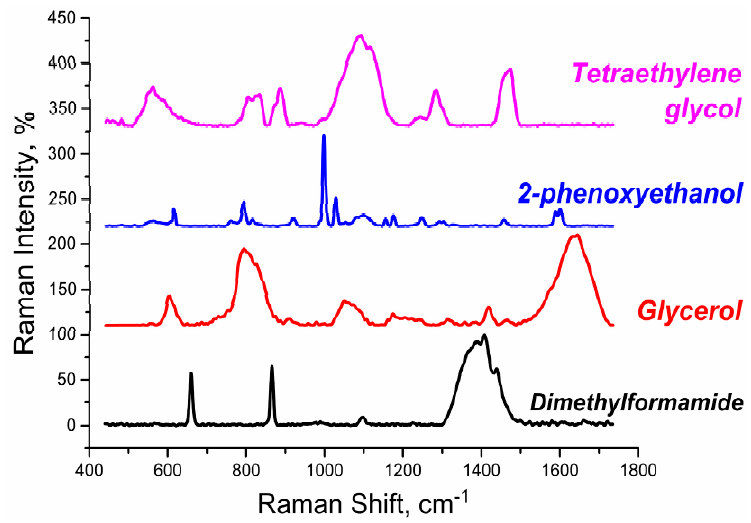
Figure 6. Raman spectra of pure solvents involved in the composition of different types of writing ink. Table 5. Comparison of the Raman peaks of writing inks with respect to the Raman peaks of the corresponding pure solvents.